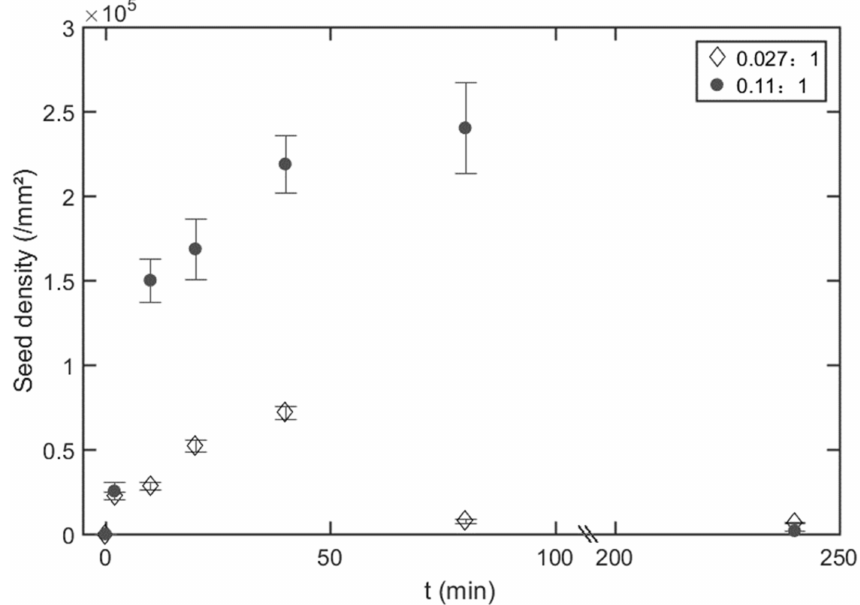
Figure 6. Variation of number density of particles with annealing